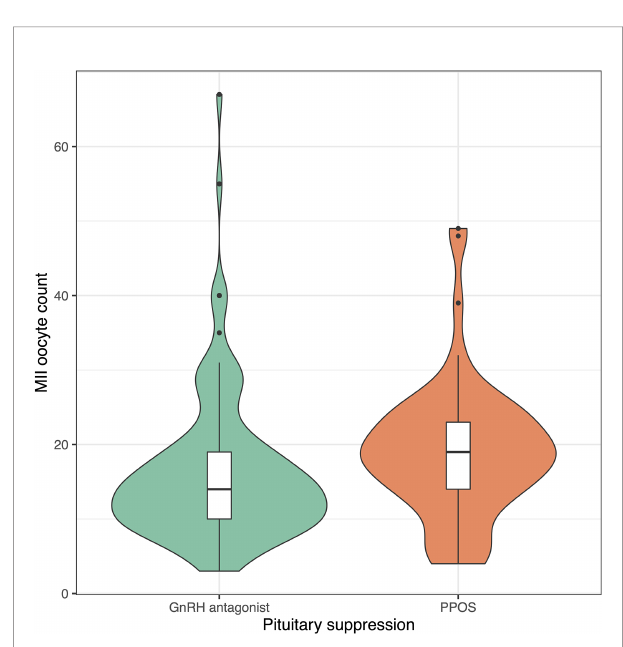
FIGURE 2 | Violin plots showing metaphase-II oocyte count in cycles suppressed with GnRH antagonists (green) and progestins (orange). Colored shaded areas show the distribution density. Lower and upper bounds of box plots show the interquartile range and horizontal dash shows the median. Black dots show potential outliers. GnRH, gonadotrophin-releasing hormone; PPOS, progestin-primed ovarian